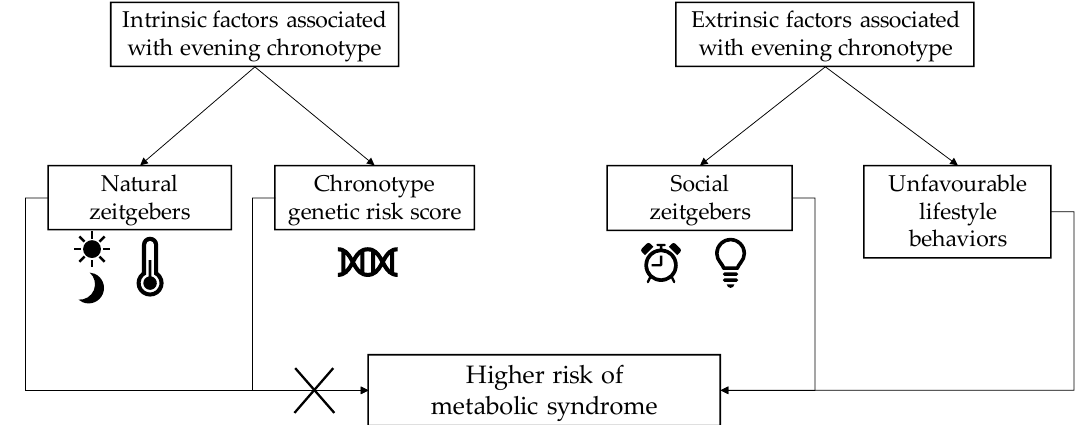
Figure 1. Schema showing the roles of intrinsic and extrinsic factors associated with evening chronotype in the risk of developing metabolic syndrome.